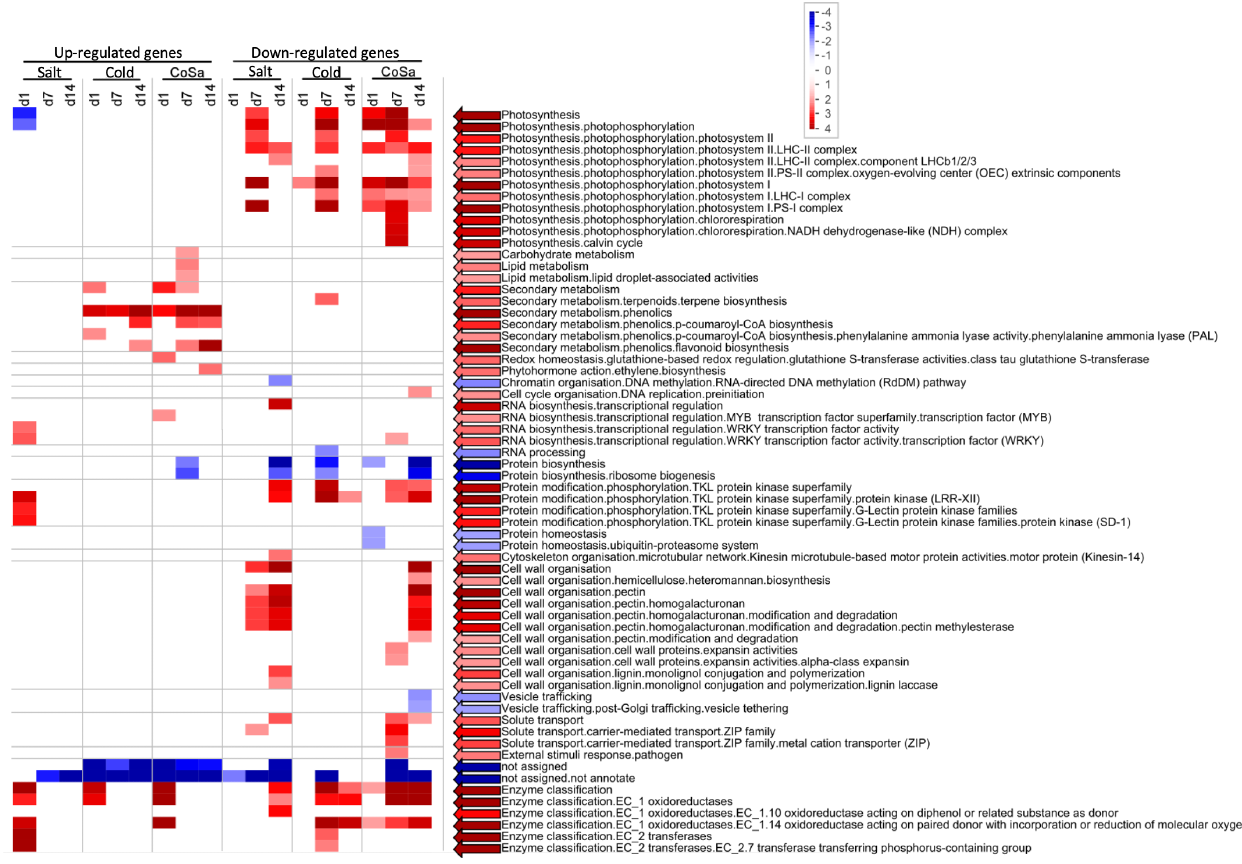
Figure 4. Overrepresentation analysis (ORA) performed for up- or down-regulated DEG of CAP1035. Plants were grown under different abiotic stress conditions (Salt, chilling temperatures: Cold, and combinations thereof: CoSa) on rockwool. The leaf after first branching was harvested and a transcriptome anaylsis performed comparing the different stress conditions with the control sample. The over- or underrepresentation of indicated Mercator [71] bins were calculated separately for up- (left column) and down-regulated genes (right column) using a Fisher test [65] in combination with a multiple testing correction as performed by Benjamini and Hochberg [72]. Overrepresented bins are shown in red and underrepresented bins in blue, respectively.